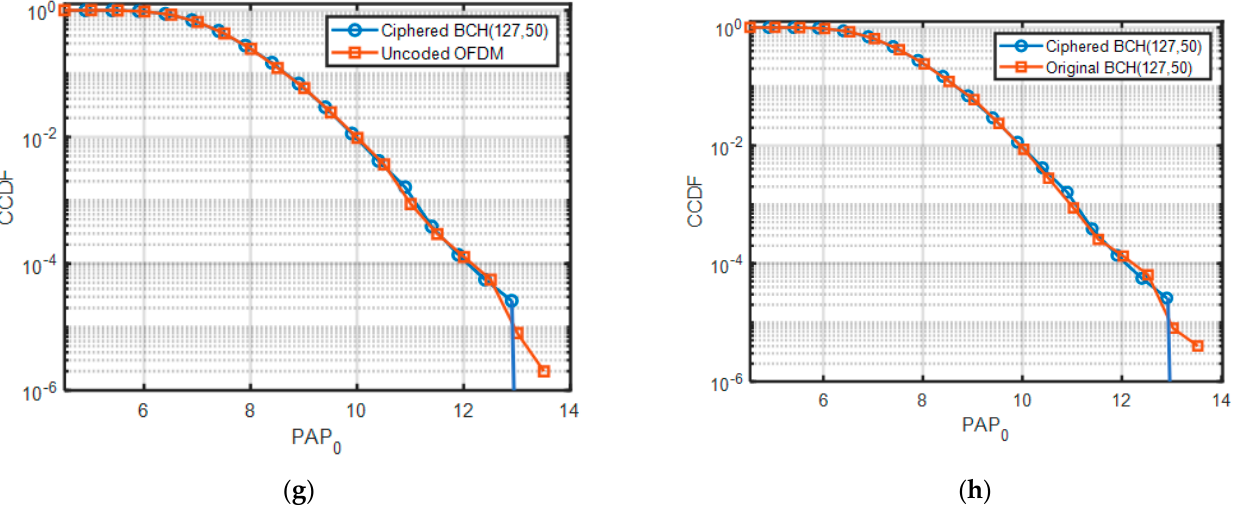
Figure 10. PAPR performance of the proposed technique for ciphered BCH (127, 𝑘) systems. (a) Ciphered BCH(127,8) vs uncoded OFDM, (b) Ciphered BCH(127,8) vs original BCH(127,8), (c) Ciphered BCH(127,22) vs uncoded OFDM, (d) Ciphered BCH(127,22) vs original BCH(127,22), (e) Ciphered BCH(127,36) vs uncoded, (f) Ciphered BCH(127,36) vs original BCH(127,36), (g) Ci- phered BCH(127,50) vs uncoded and (h) Ciphered BCH(127,50) vs original BCH(127,50).